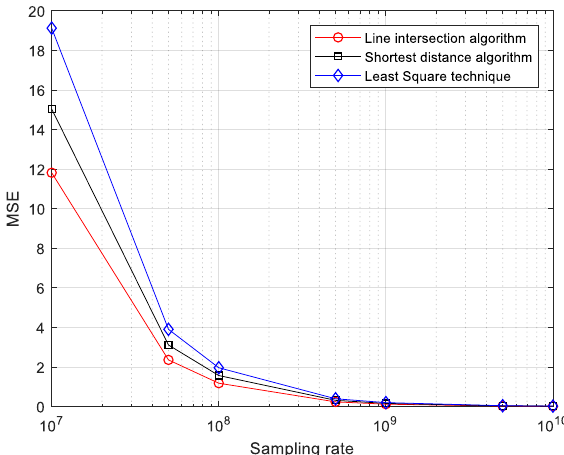
Figure 11. MSE of MS position estimation using the shortest distance and the line intersection algorithms for the third case.